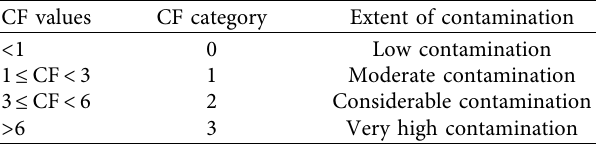
Table 5: The various categories of contamination factors. CF values CF category Extent of